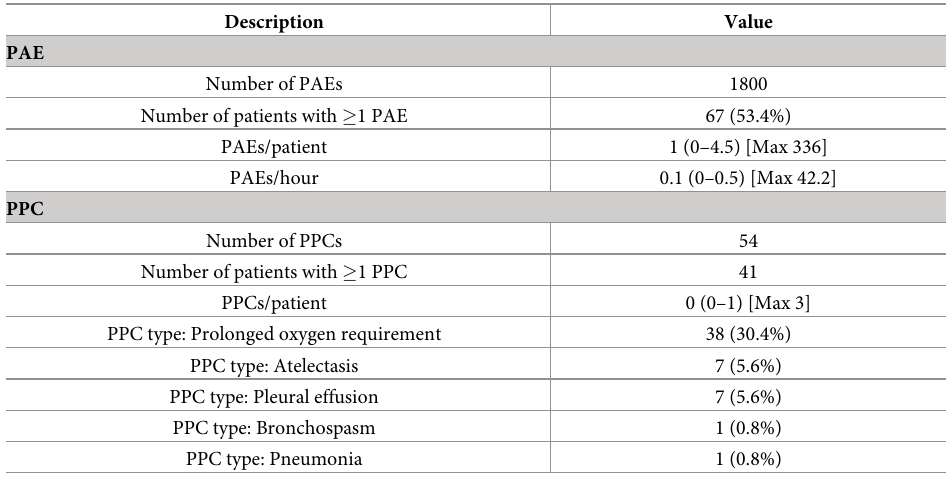
Table 2. Descriptive statistics for PAEs and PPCs.